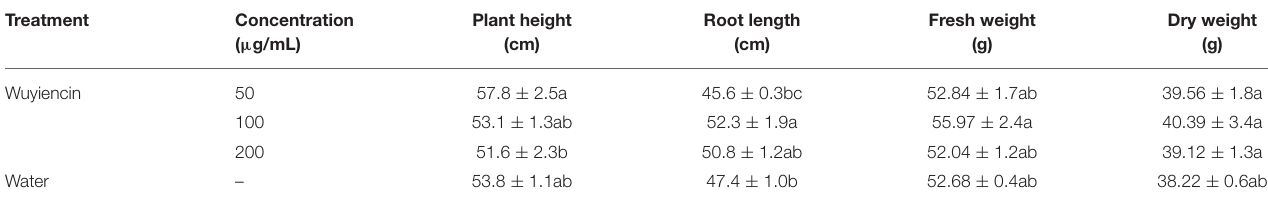
TABLE 4 | Effects of wuyiencin by spraying on soybean plant growth. Treatment